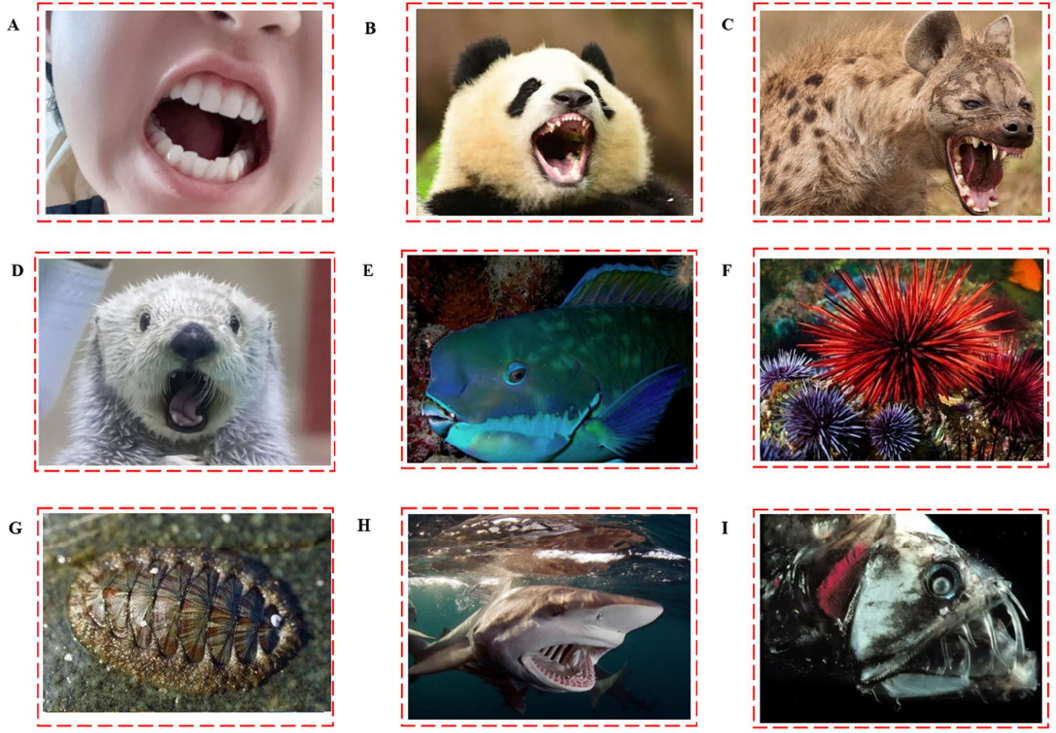
Figure 1. Representative animals covered in this review. ( A ) Human. ( B ) Panda. ( C ) Hyena. ( D ) Sea otter. ( E ) Parrotfish. ( F ) Sea urchin. ( G ) Chiton. ( H ) Shark. ( I ) Dragonfish. Whenever relevant, im- ages were reproduced with permission from the